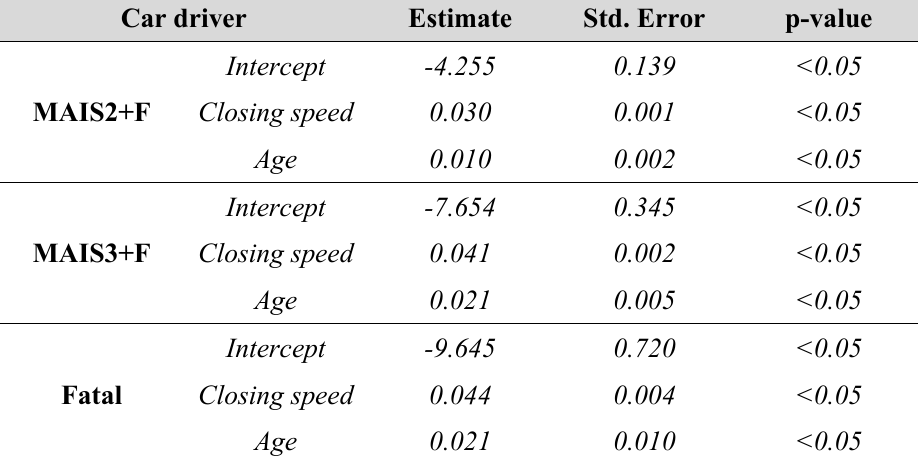
Table 5. Car driver injury risk models: Logistic regression coefficient estimates according to Equation